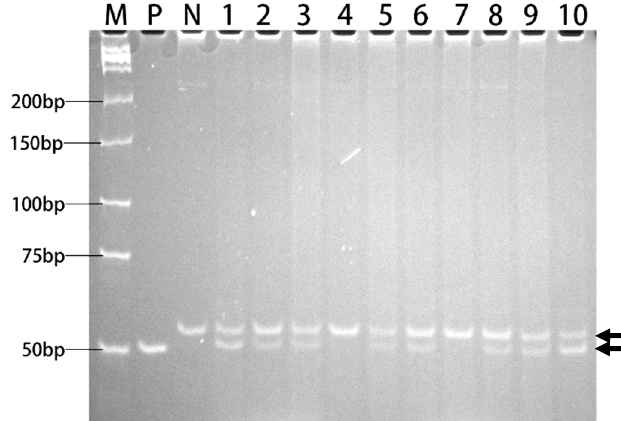
Figure 6. PAGE analysis of PCR products for ahas fragments. Lane 1-10: PCR products from Line 1-10 of transgenic rice. P: positive control (plasmid DNA of 1300-AHAS- Δ W548). N: negative control (genomic DNA of Xiushui134). M: Low MW DNA marker-A. The molecular weights were indicated. Two arrows showed two amplified fragments: upper arrows indicated wildtype ahas fragments, lower arrows indicated ahas- Δ W548 fragments.